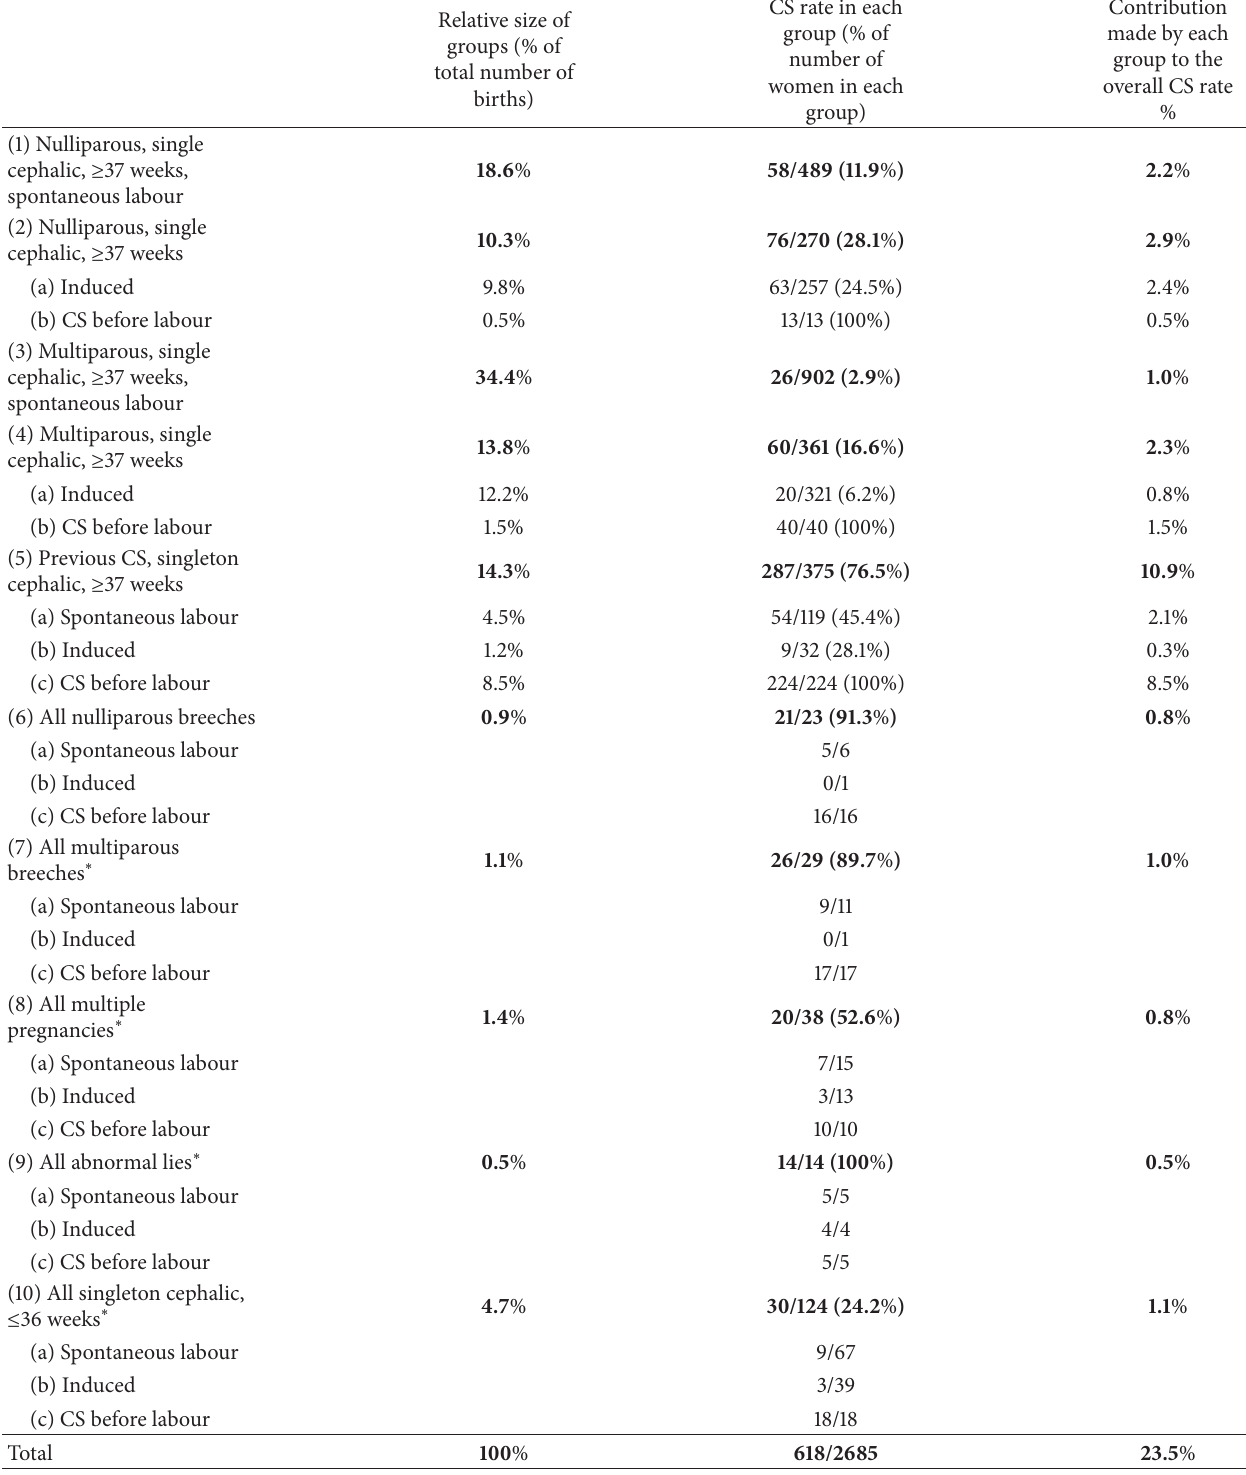
Table 1: Rate of Caesarean section by the Ten-Group Robson